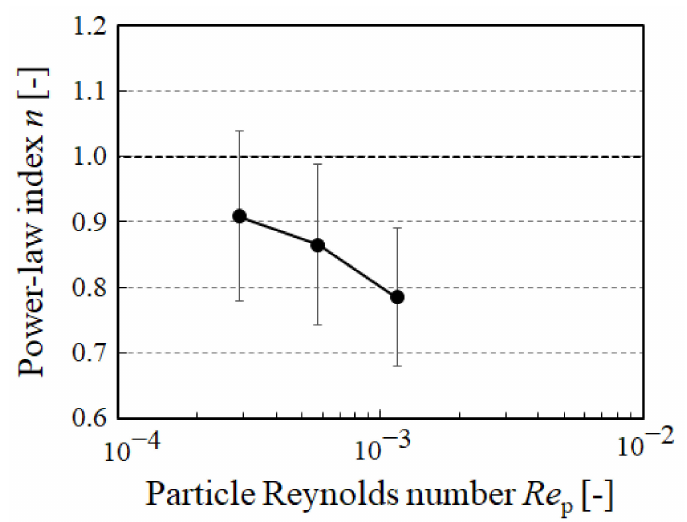
Figure 6. Relationship between power-law index n and particle Reynolds number Re p . The plots are the mean ± 1 SD.